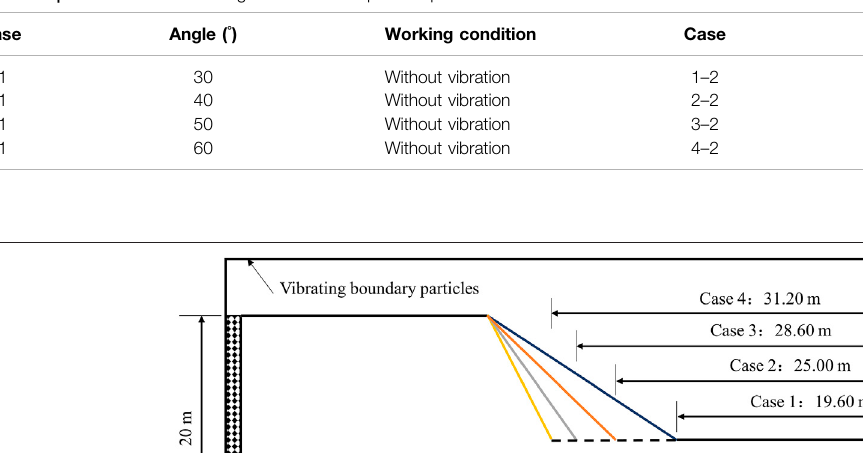
TABLE 4 | Table of parameters in SPH simulation of soil